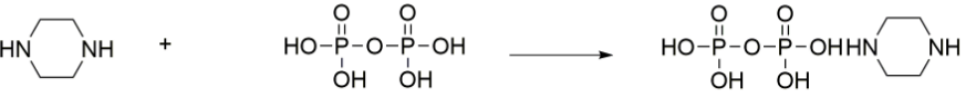
Figure 5. Piperazine pyrophosphate [59].